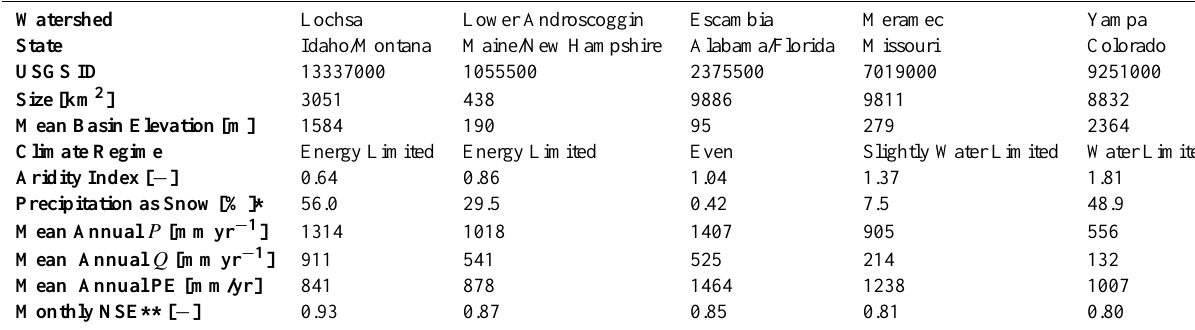
Table 1. Description of validation watersheds for the base period 1958–1968.